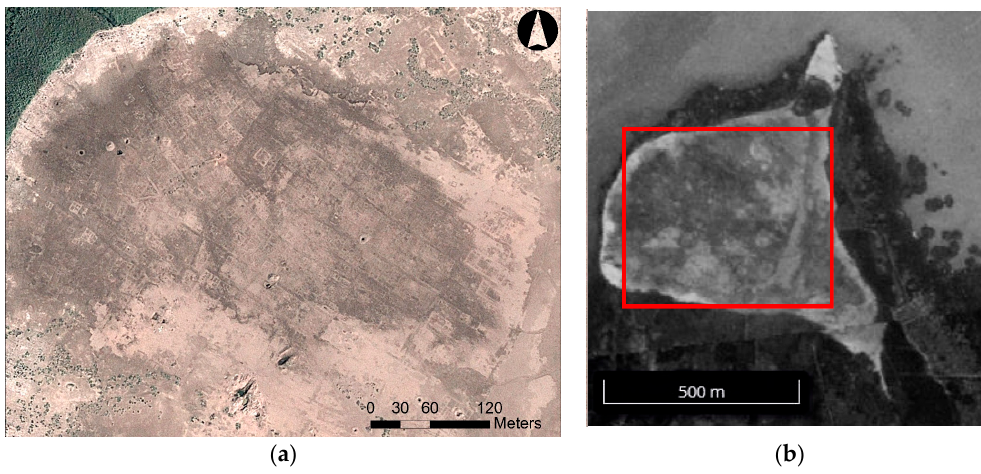
Figure 11. ( a ) The site of Kom ed Dahaba. Image courtesy Google Earth; ( b ) 1968 CORONA image. Area in image ( a ) is within the red box. Image courtesy of the Center for Advanced Spatial Technologies, University of Arkansas/U.S. Geological Survey.